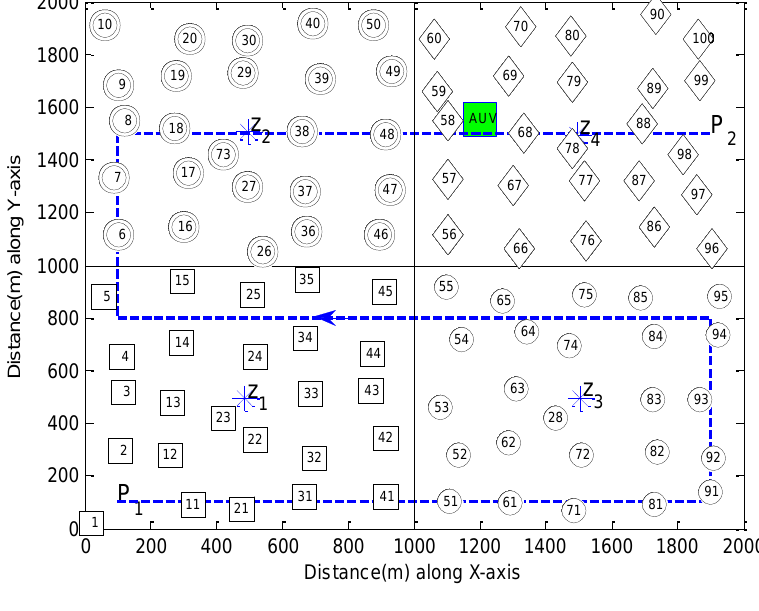
Figure 4. UWSN with four clusters after